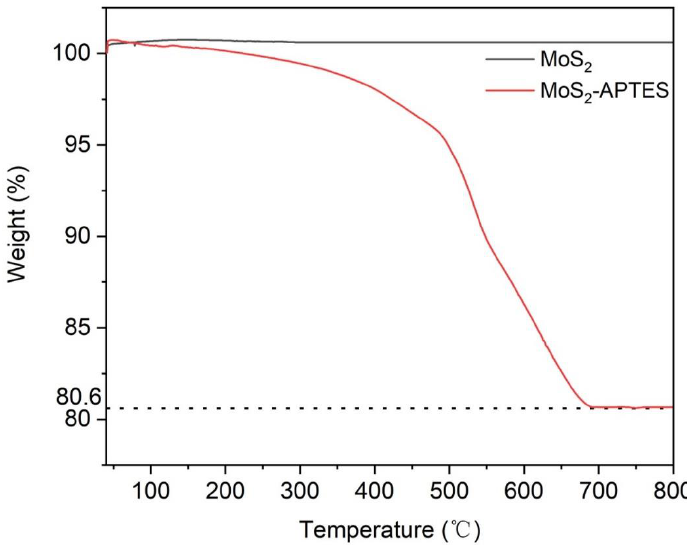
Figure 5. TGA curves of MoS 2 and MoS 2 -APTES.